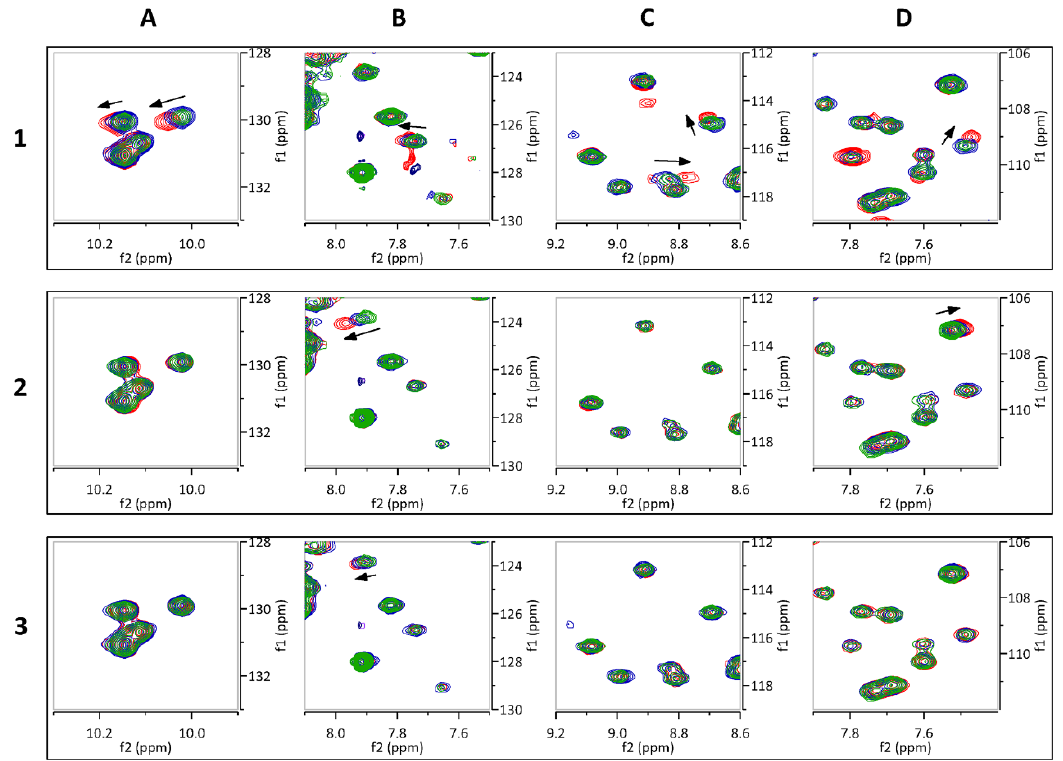
Figure 5. 1 H- 15 N HSQC spectrum of the periplasmic domain of FtsQ. The five tryptophan residues give clear distinguishable signals at a 10–11 ppm shift. Area’s ( A – D ) show the portions of the spectrum from which the zooms showing chemical shifts perturbations were taken, as shown in Figure 6.